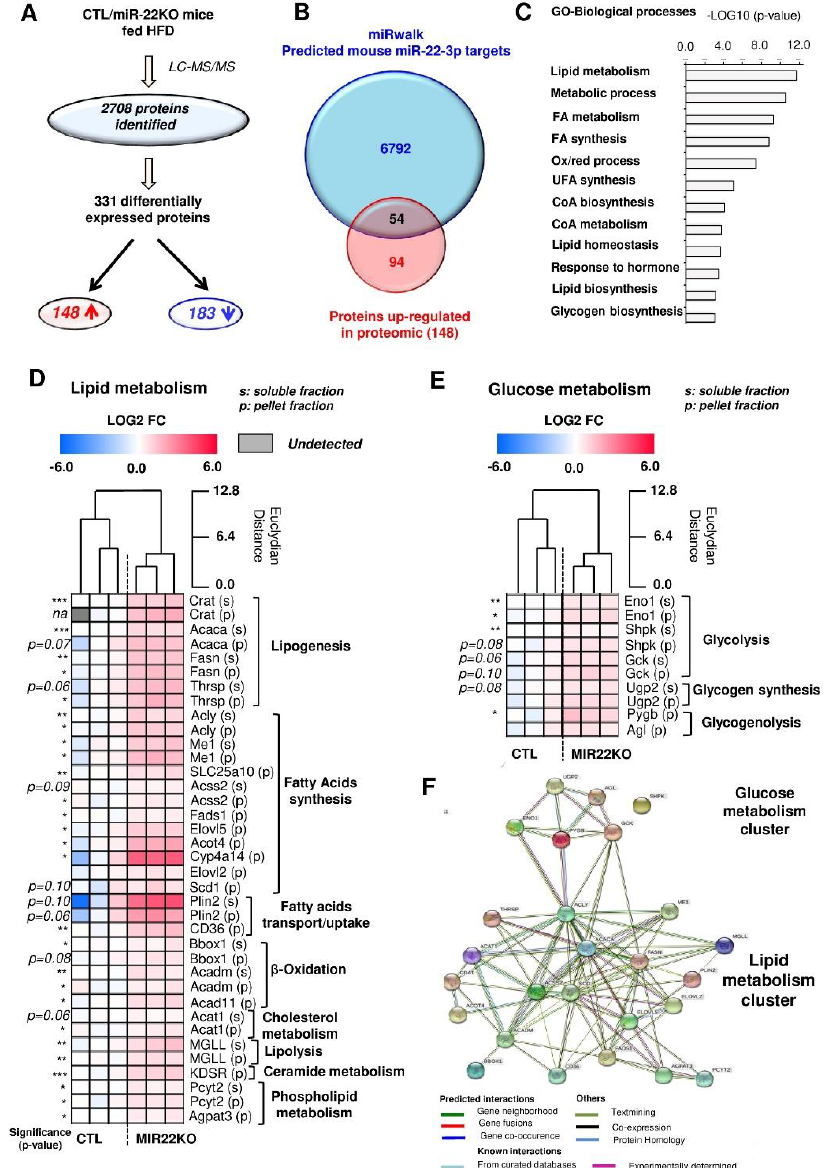
Figure 4. Hepatic proteomic analysis highlights important metabolic deregulations in miR-22KO mice. Two-months-old CTL and miR-22KO mice were fed high fat diet (HFD) for 12 weeks before processing explanted liver tissues for mass spectrometry analysis. ( A ) Workflow of the proteomic data analysis. ( B ) Cross-comparison of hepatic proteins up-regulated by Mir22 deficiency with predicted mouse miR-22-3p targets according to miRwalk 2.0. ( C ) Gene-Ontology (GO) enrichment analysis for biological processes performed on the common candidates from panel B (54 candidates). 30 candidates were identified as key factors involved in lipid and glucose metabolism (based on Uniprot annotation) and potentially regulated directly by miR-22-3p. Relative protein level variations between CTL and miR-22KO mice are represented in heatmaps ( D,E ). ( F ) Graphic representation of the interaction of the proteins (glucose and lipid metabolism), whose mRNAs are predicted to be miR-22 targets and found upregulated in miR-22KO livers of mice challenged with 12 weeks of HFD. The representation was done via the STRING database software. (n = 5–10 per group and data are mean ± SEM, Panels D and E were analyzed via Student T test). * p < 0.05, ** p < 0.01, *** p < 0.001.